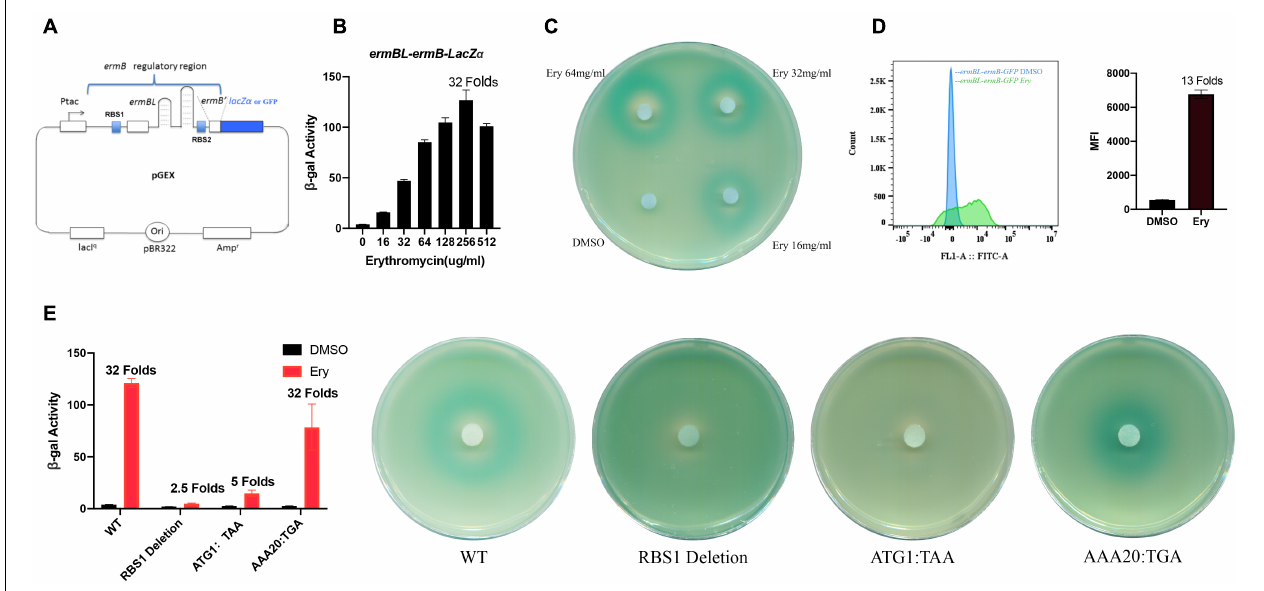
FIGURE 1 | N-terminal, not C-terminal, region of ermBL is necessary for ermB induction by erythromycin. (A) The structure of the ermBL-ermB -based pGEX reporter plasmid. (B) β -Galactosidase activity of the ermBL-ermB-lacZ α reporter gene during erythromycin (Ery) titration. Data are mean ± SEM from three independent experiments (unpaired two-tailed Student’s t -test). (C) Agar diffusion assays of cells transformed with the reporter plasmid containing ermBL grown on plates with IPTG and X-gal; each filter disc was spotted with different concentration of Ery and DMSO. (D) Flow cytometry of GFP intensity is shown. Data are mean ± SEM from three independent experiments (unpaired two-tailed Student’s t -test). (E) β -Galactosidase activity and agar diffusion assays of different premature terminations of ermBL. Plate were wetted with 1 µ L of a solution of Ery (128